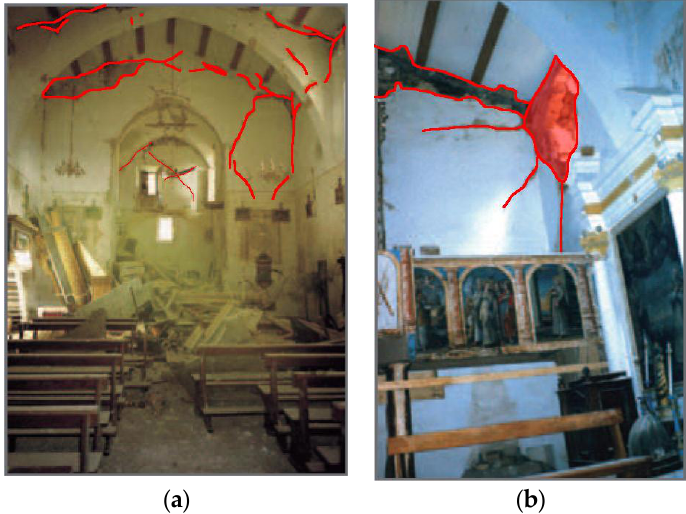
Figure 14. Post-1997 earthquake damage of the interior of the church. Photo source: [57]. ( a ) View of the triumphal arches towards the apse area. Diffuse shear cracks and pounding damage. ( b ) Inside view of St. Salvatore church. Partial collapse of the wall and of part of the internal leaf of the wall of the main façade at the tympanum level.